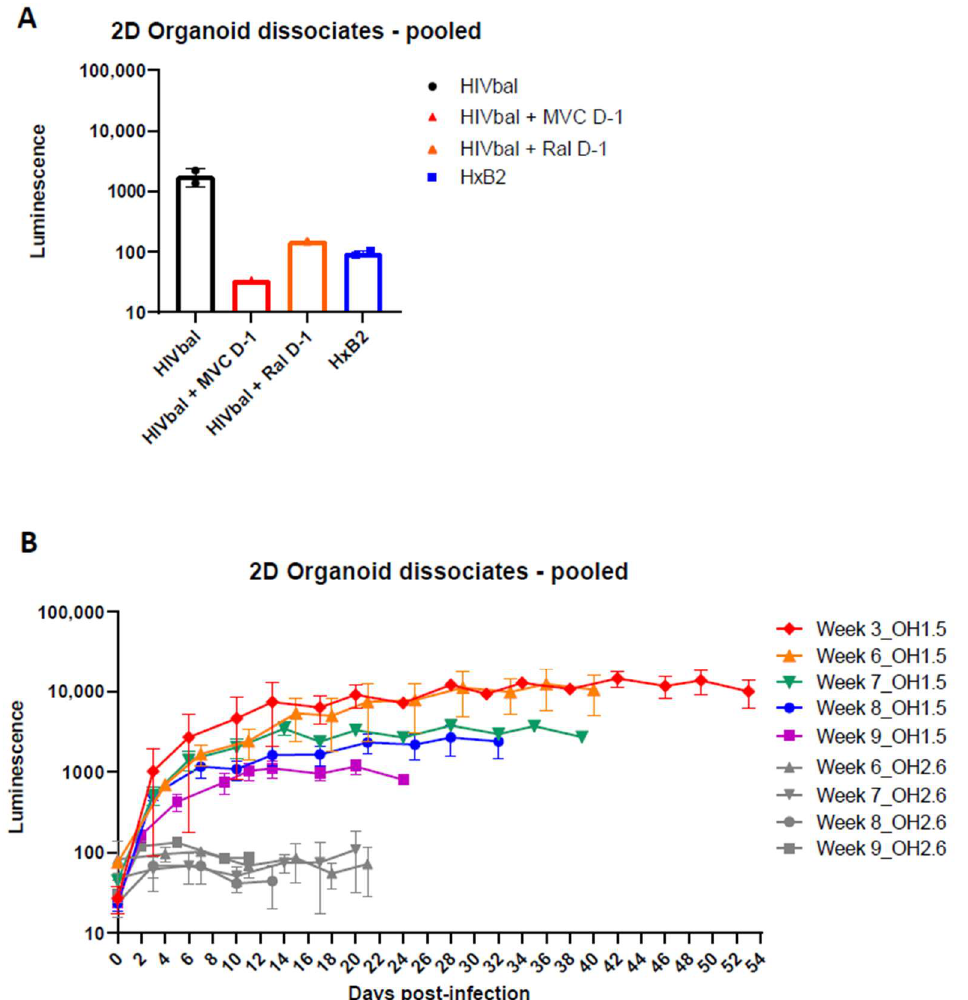
Figure 3. Two-dimensional organoid dissociates support productive HIV-1 infection. ( A ) Week 5 2D organoid dissociates were infected with HIVbal and HxB2 and treated with MVC (100 nM) and Ral (200 nM) pre-infection (D-1). Bar graphs represent luciferase activity measured in supernatant collected on Day 14, post-infection. ( B ) 2D organoid dissociates starting from week 3 up to week 9 were infected with HIVbal. Cerebral organoids were derived from iPSC line OH1.5 or OH2.6. Supernatants were collected at each timepoint. Both graphs depict the means ± standard errors of the means.